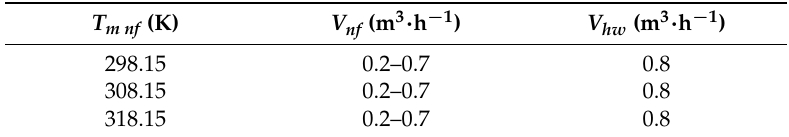
Table 3. Nanofluid temperatures ( T m nf ), nanofluid flow rates ( V nf ) and heating water flow rates ( V hw ) for the convection coefficient and pressure drop